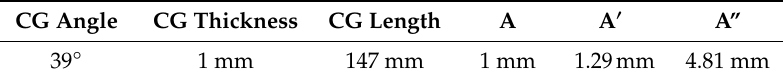
Table 2. Geometric specifications of cover glass.